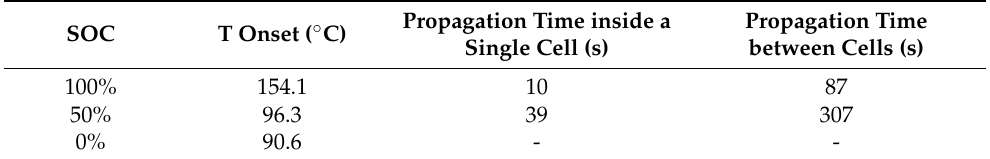
Table 1. Effect of SOC on onset temperature of thermal runaway, propagation time in a single cell, and propagation time between cells in